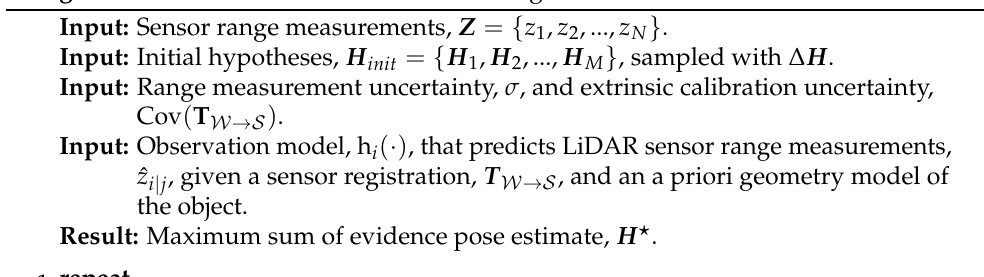
Algorithm 1: Maximum Sum of Evidence